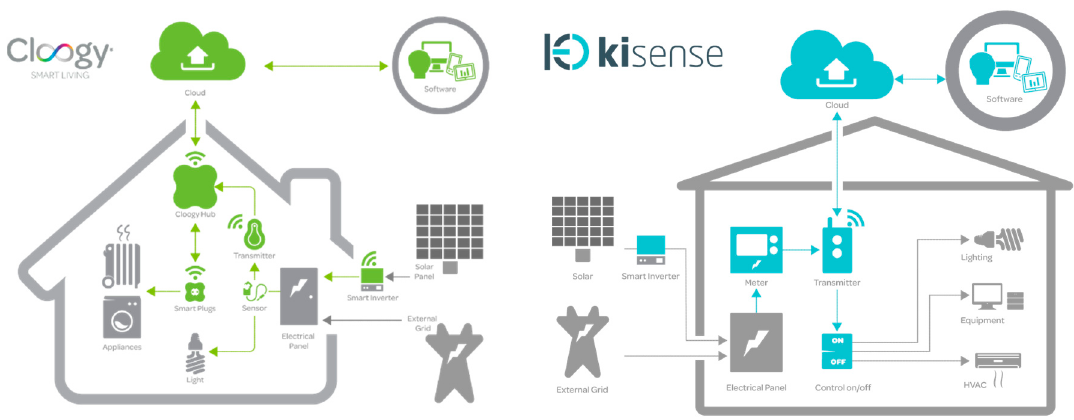
Figure 1. Cloogy and Kisense’s schematic representation. Source: Authors’ own elaboration.